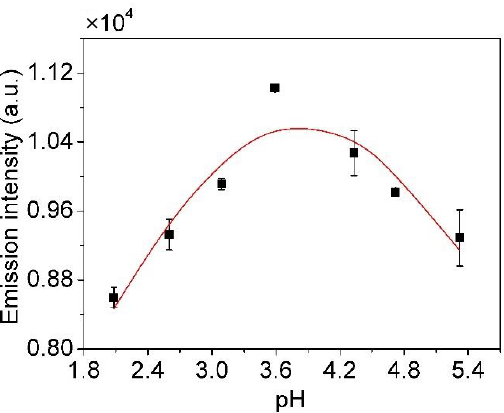
Figure 9. The effect of the solution pH on emission intensity (applied voltage: 5.6 kV, Ar flow rate: 1.68 L/min, no organic matter added).